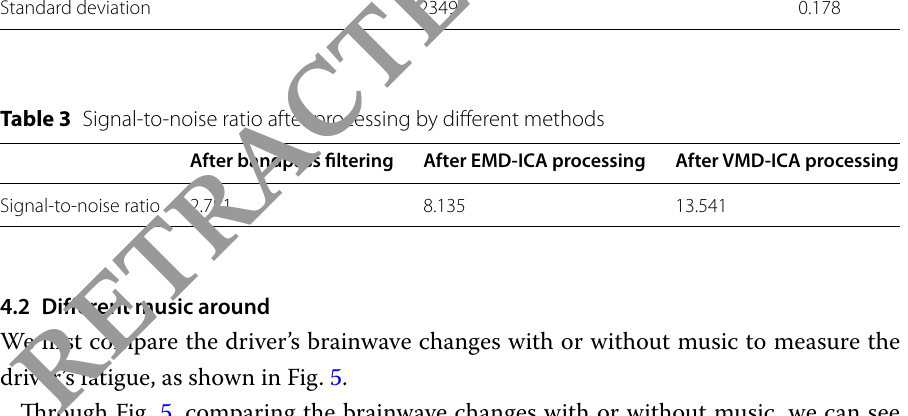
Table 2 Comparison of sample entropy of EEG component and EOG component Sample entropy EEG component Mean